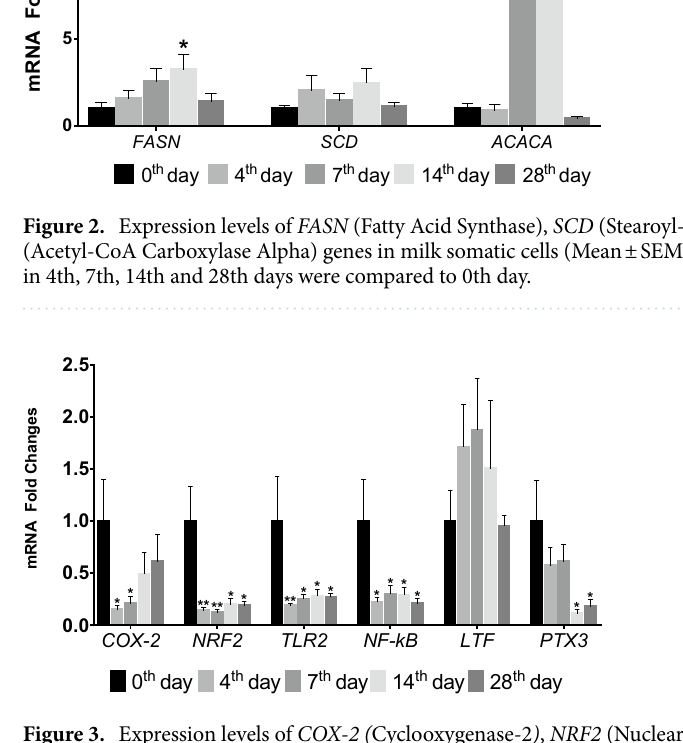
Figure 3. Expression levels of COX-2 ( Cyclooxygenase-2 ) , NRF2 (Nuclear Factor Erythroid 2-related Factor 2), TLR2 (Toll-like Receptor 2), NF-kB (Nuclear Factor Kappa B), LTF (Lactoferrin), and PTX3 (Pentraxin 3) genes in milk somatic cells (Mean ± SEM); *: P < 0.05; **: P < 0.01, Fold change differences in 4th, 7th, 14th and 28th days were compared to 0th